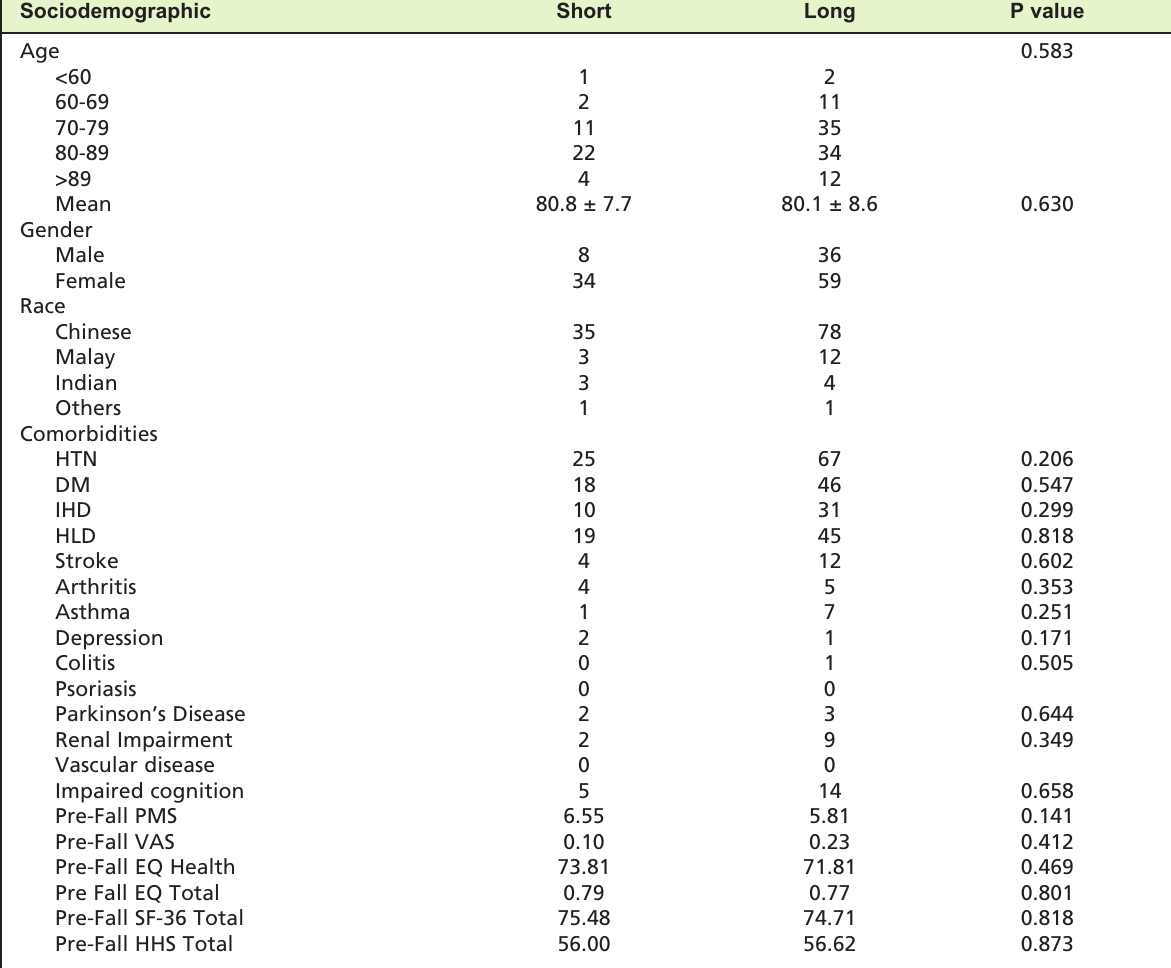
Baseline Table I: